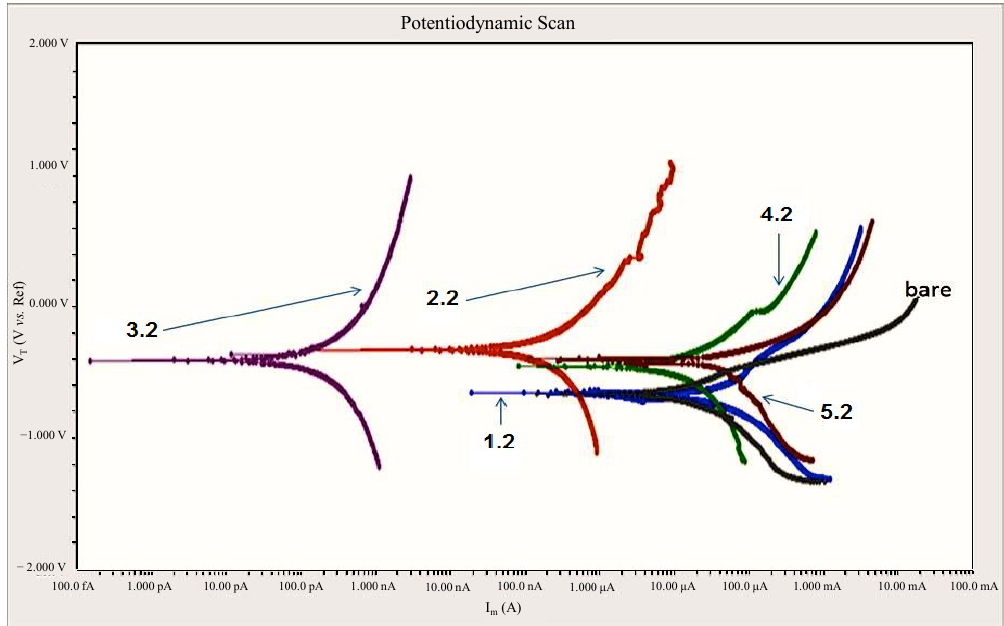
Figure 5. Potentiodynamic Polarization Curves of CR-coated samples and a bare substrate (without